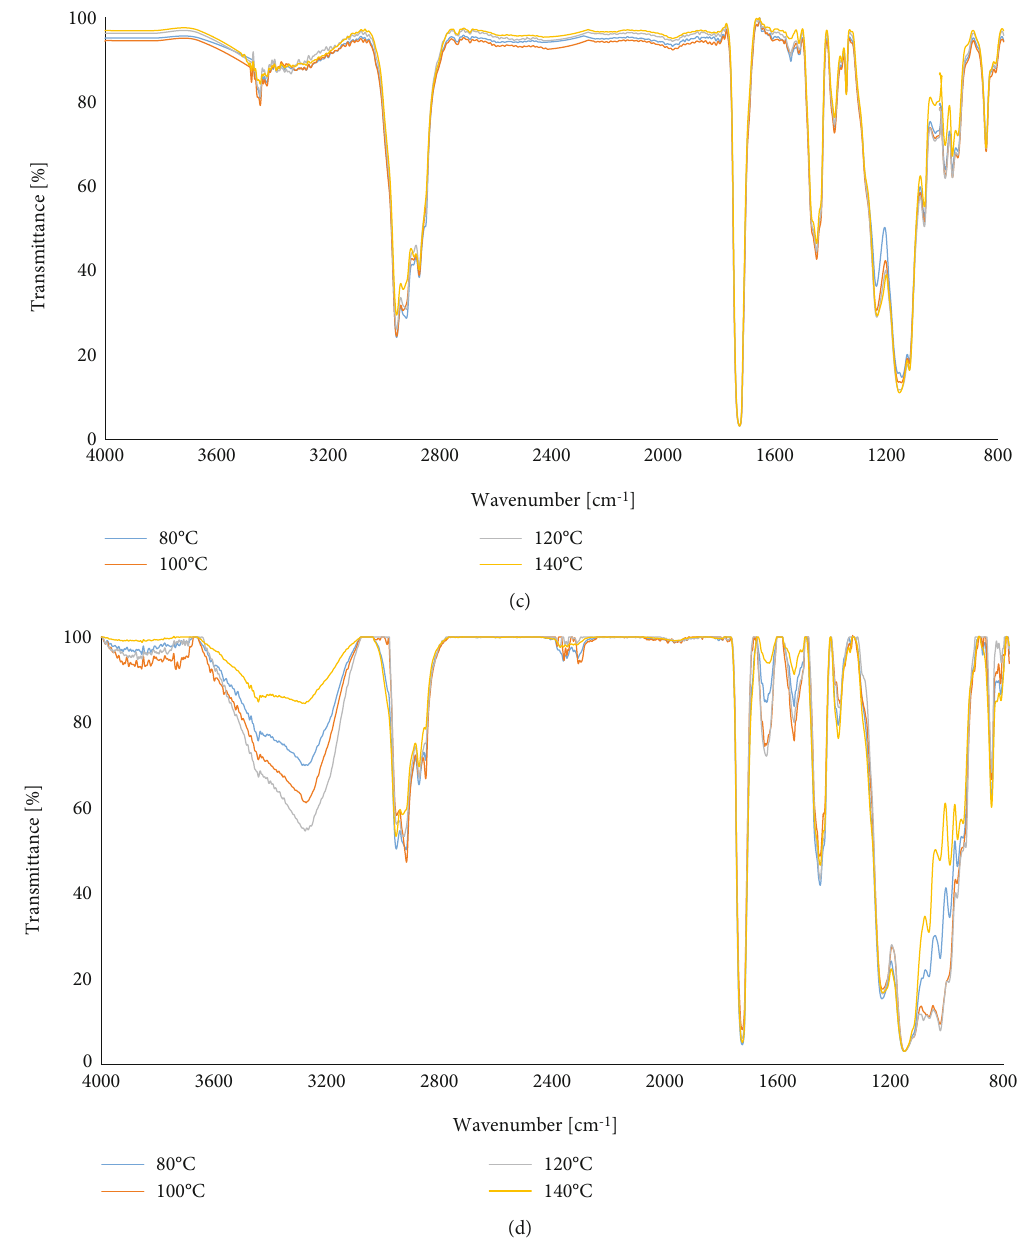
Figure 8: FTIR curves of OPEFB/acrylic thermoplastic composites (a) before aging — 605 μ m, (b) after aging — 605 μ m, (c) before aging — 633 μ m, and (d) after aging — 633 μ m. Table 1: Thermogravimetric results of raw materials at di ff erent decomposition